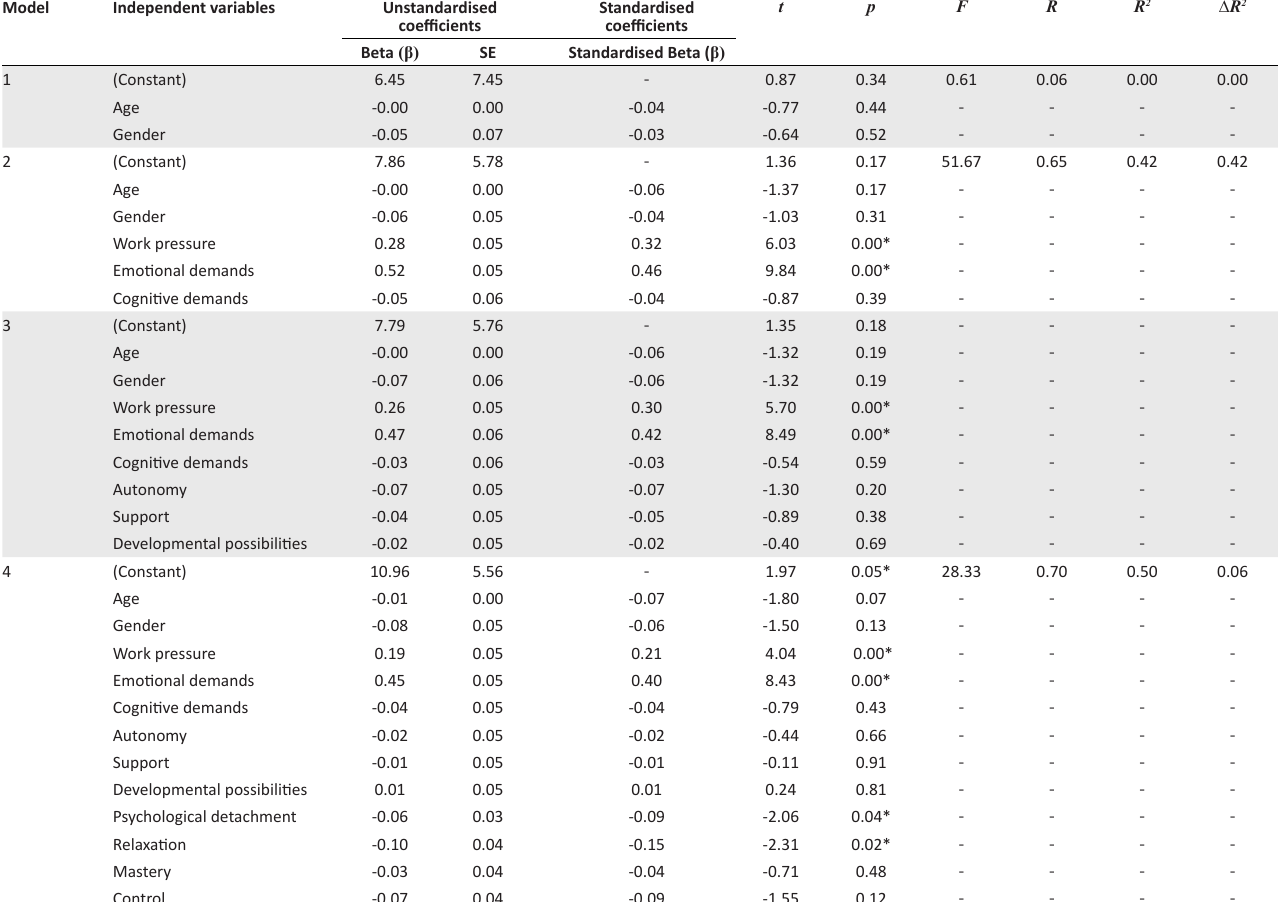
TABLE 3: Multiple regression analysis with work-spouse interference as dependent variable.